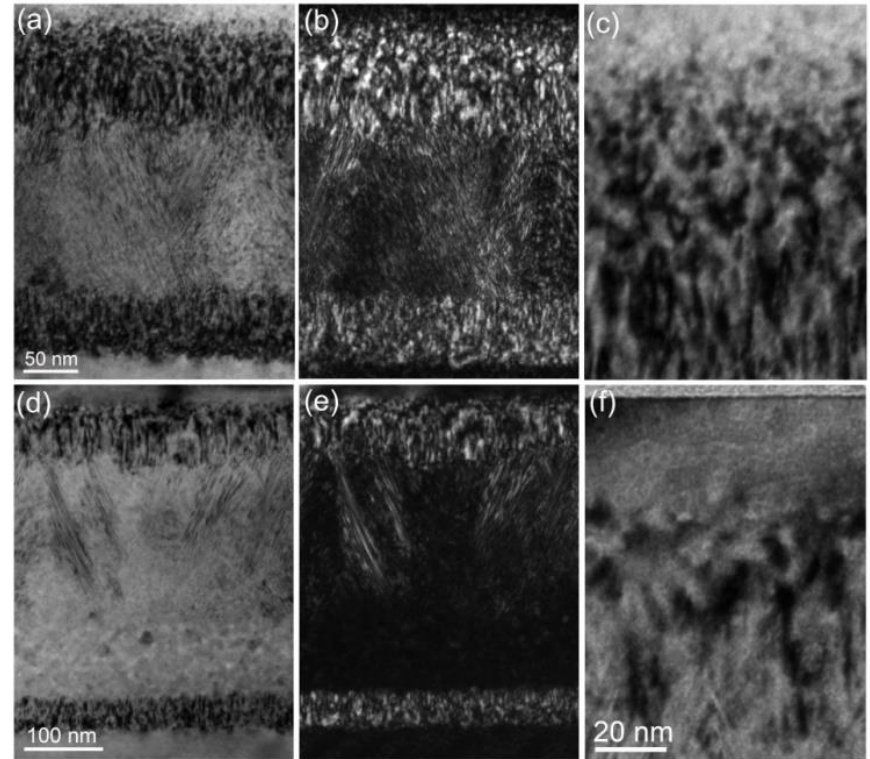
Figure 3. XTEM microstructural images of the damaged band observed under ( a ), ( d ) bright field and ( b ), ( e ) weak-beam dark field ((g, 5g), g = 0002) (a and b for the low fluence, d and e for the high fluence), ( c ) and ( f ) magnified images taken from the upper damage band of ( a ) and ( d ), respectively. The sample surface is vertical and upright.